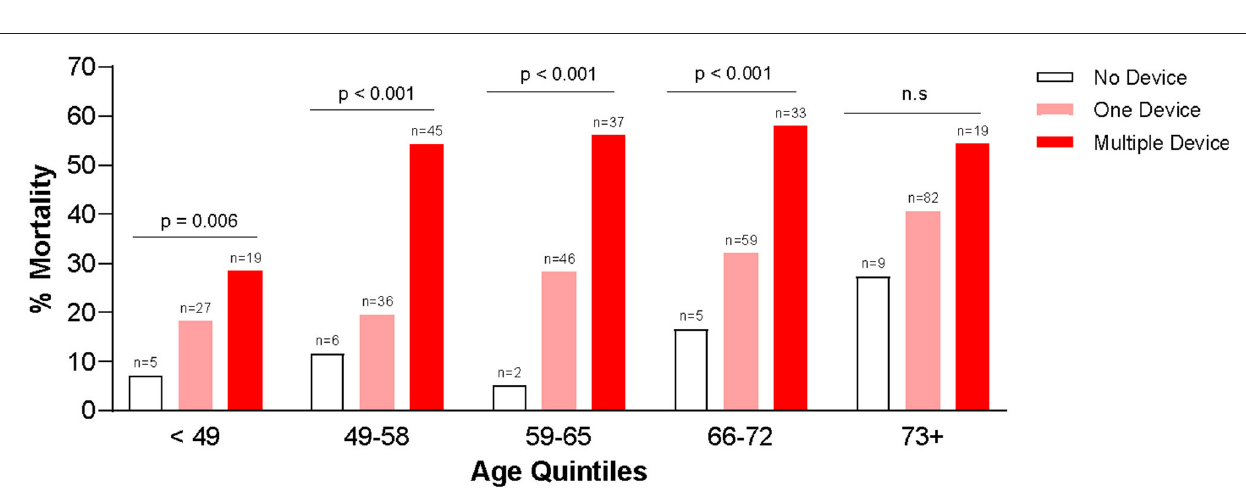
FIGURE 3 | Association between in-hospital mortality and use of temporary mechanical circulatory support